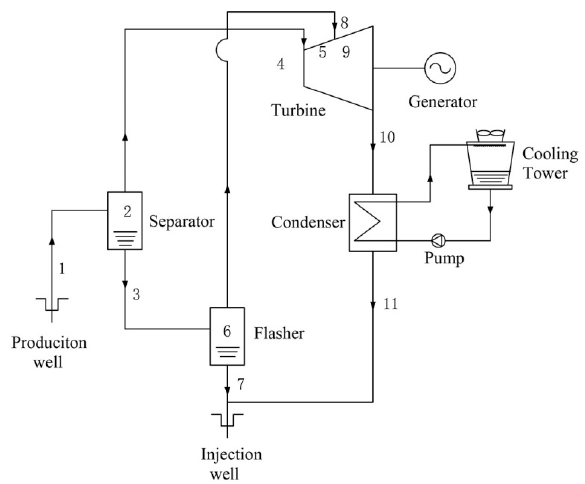
Figure 2. Double ‐ flash (DF) system.